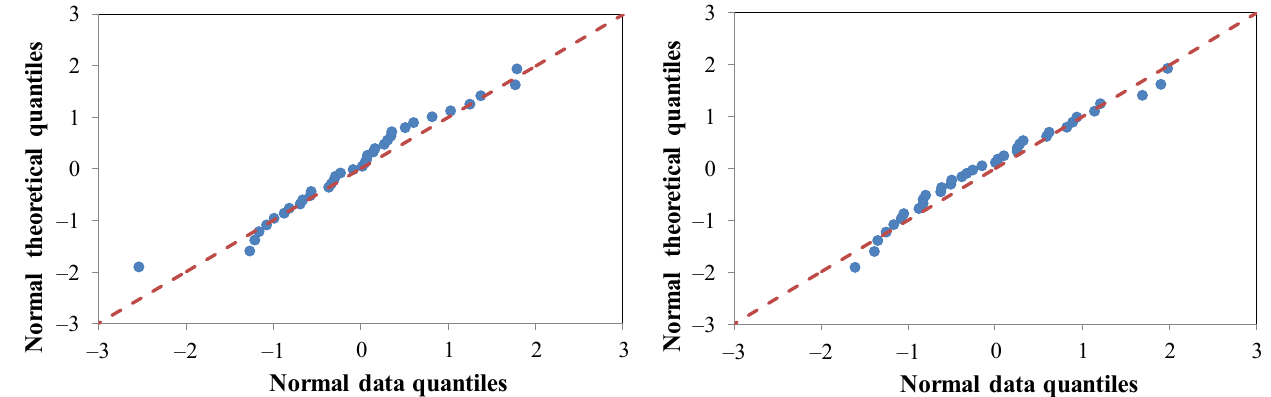
Figure 13. Examples of Normal Quantile-Quantile plots for two different records.